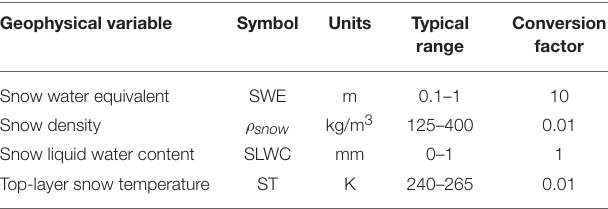
TABLE 2 | List of Noah-MP simulated geophysical variables used as input for SVM training and prediction with corresponding units and conversion factors. Geophysical